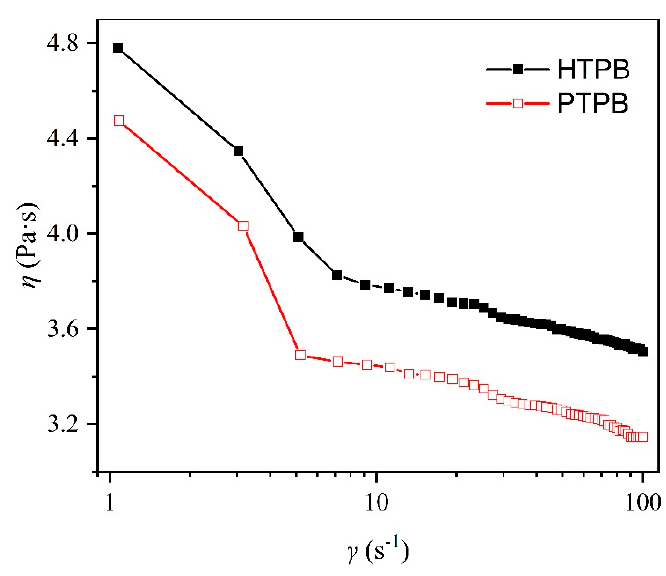
Figure 4. Dependences of viscosity on shear rates for PET and ATPET.